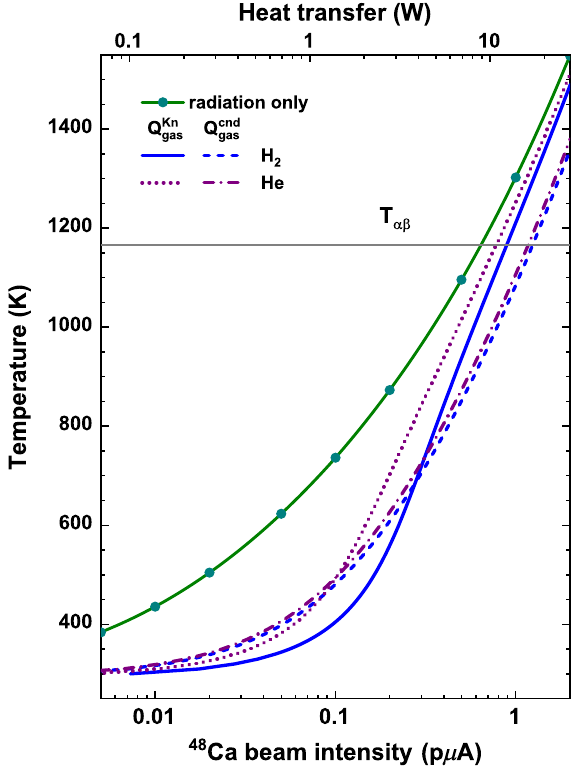
FIG. 7. Temperatures of a stationary target ( 0 . 5 mg = cm 2 UO 2 on 0 . 71 mg = cm 2 Ti backing) as functions of 48 Ca beam intensity for the uniform beam-density distribution throughout the target area ( r t ¼ 0 . 5 cm) surrounded by dilute H 2 or He gases. Estimates of heat removal to gas obtained with Eq. (6) and Eqs. (9) – (11) are designated as Q Kn and Q cnd (respective lines). gas gas These estimates are compared to the calculations based on radiation cooling only [5,8,11] (circles connected by solid lines). The temperature of the α − β transition in the Ti crystal is shown (horizontal line). The upper scale corresponds to the absorbed energy of 13.9 MeV